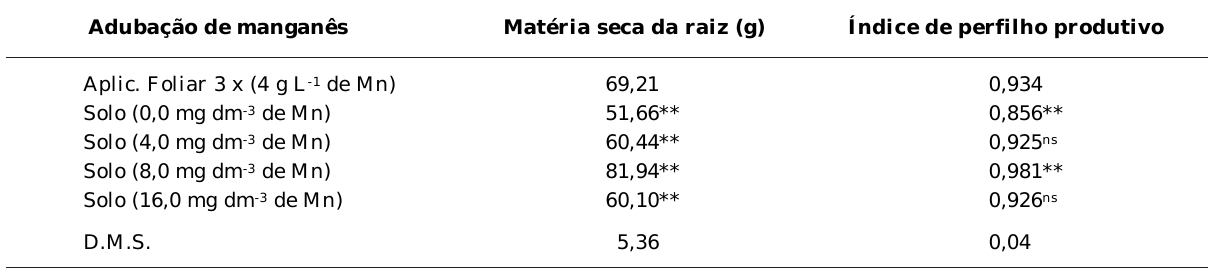
entre as aplicações via foliar e as doses via solo de Mn +2 , nas plantas de